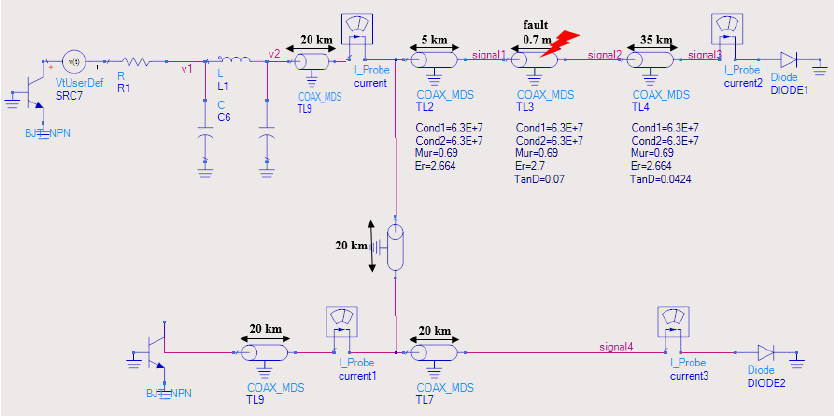
Figure 9. Equivalent circuit modeling of MTDC system: scenario 2.